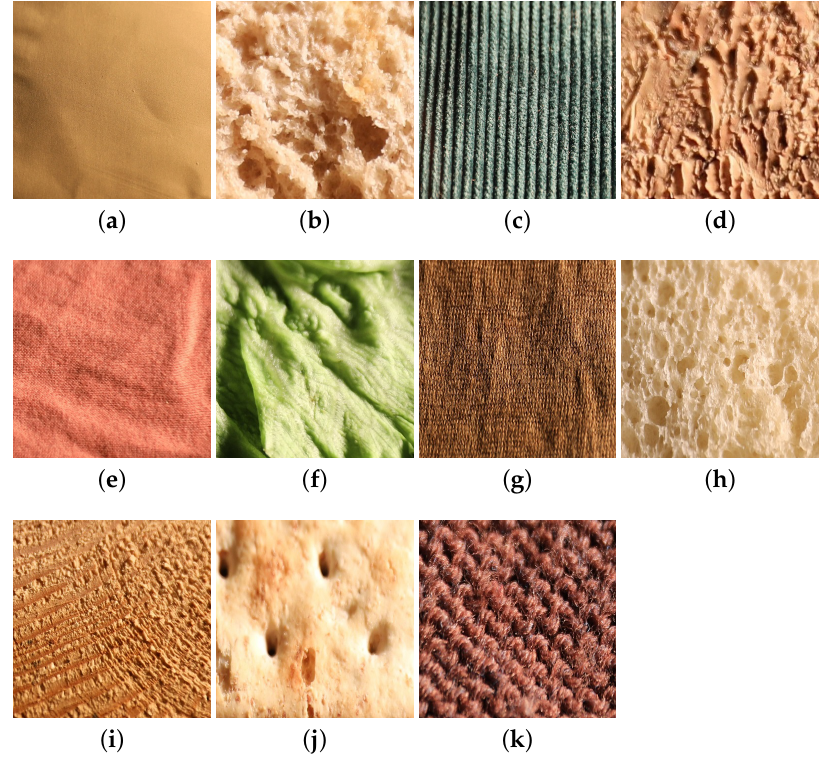
Figure 8. Images of a sample of ( a ) aluminium foil, ( b ) brown bread, ( c ) corduroy, ( d ) cork, ( e ) cotton, ( f ) lettuce leaf, ( g ) linen, ( h ) white bread, ( i ) wood, ( j ) cracker, and ( k ) wool category from the UJM-TIV dataset taken under a illumination direction of 65° and a viewing condition of